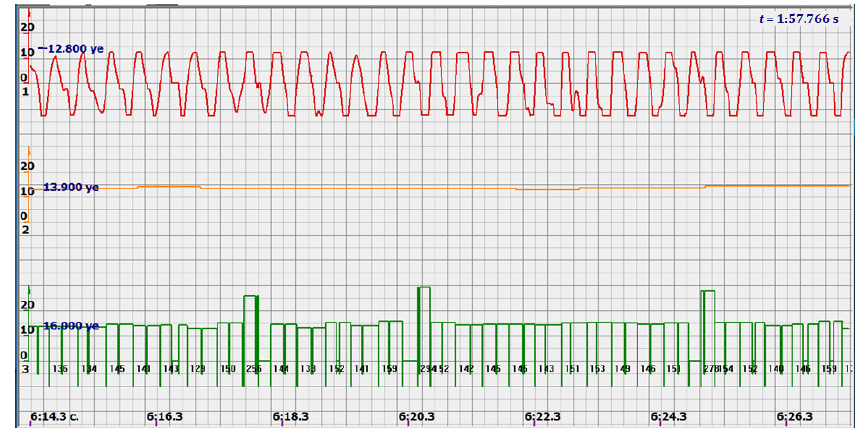
Figure 17. Heart rate—from 136 to 150 bpm.